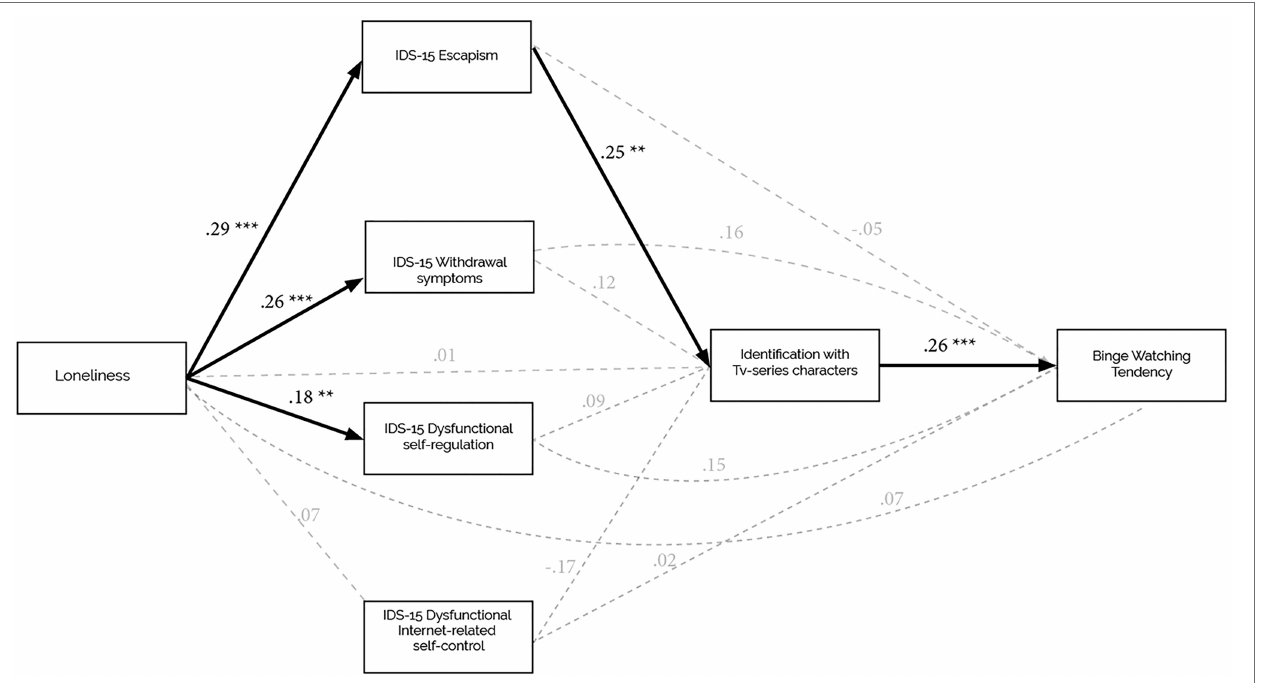
FIGURE 1 | Effects of loneliness on the tendency to binge-watch through the effects of escapism and identification with the media character. Standardized regression coefficients are reported. Bolded arrows represent statistically significant effects; dashed arrows represent non-significant effects. ** p < 0.01, *** p < 0.001.